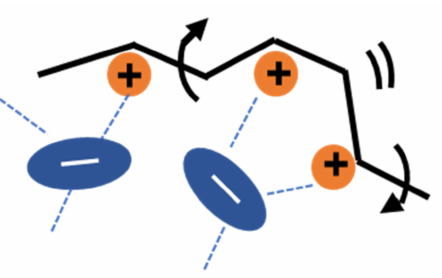
Figure 2. Schematic representation of the molecular motion responsible for the sub-Rouse mode. The free segmental movement of polymer chains is restricted by the interaction between the counter anion and polymer chain